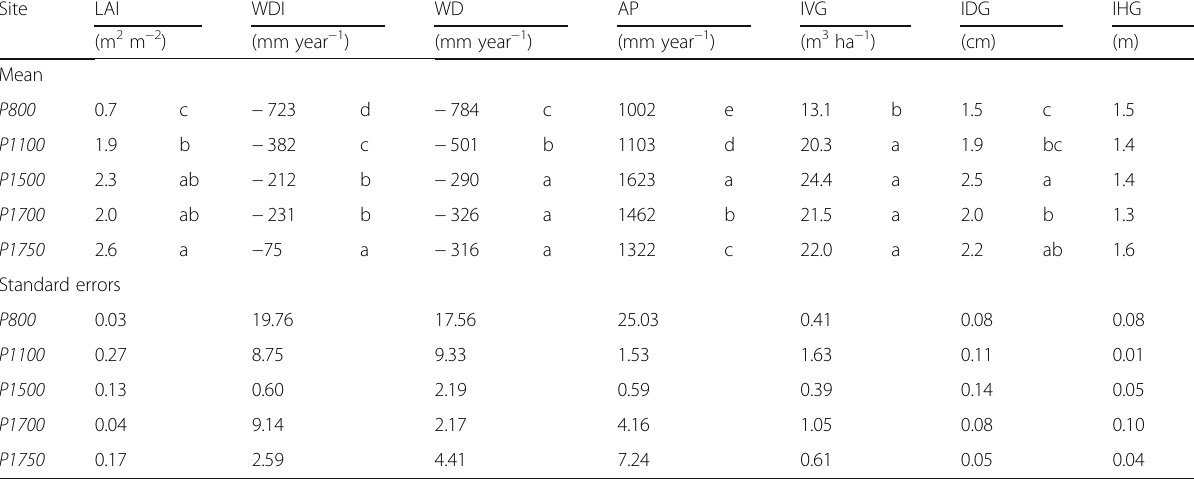
Table 3 Averages of leaf area index (LAI), water deficit index (WDI), water deficit (WD), annual precipitation (AP), volume growth (IVG), diameter growth (IDG), and height growth (IHG) for study sites